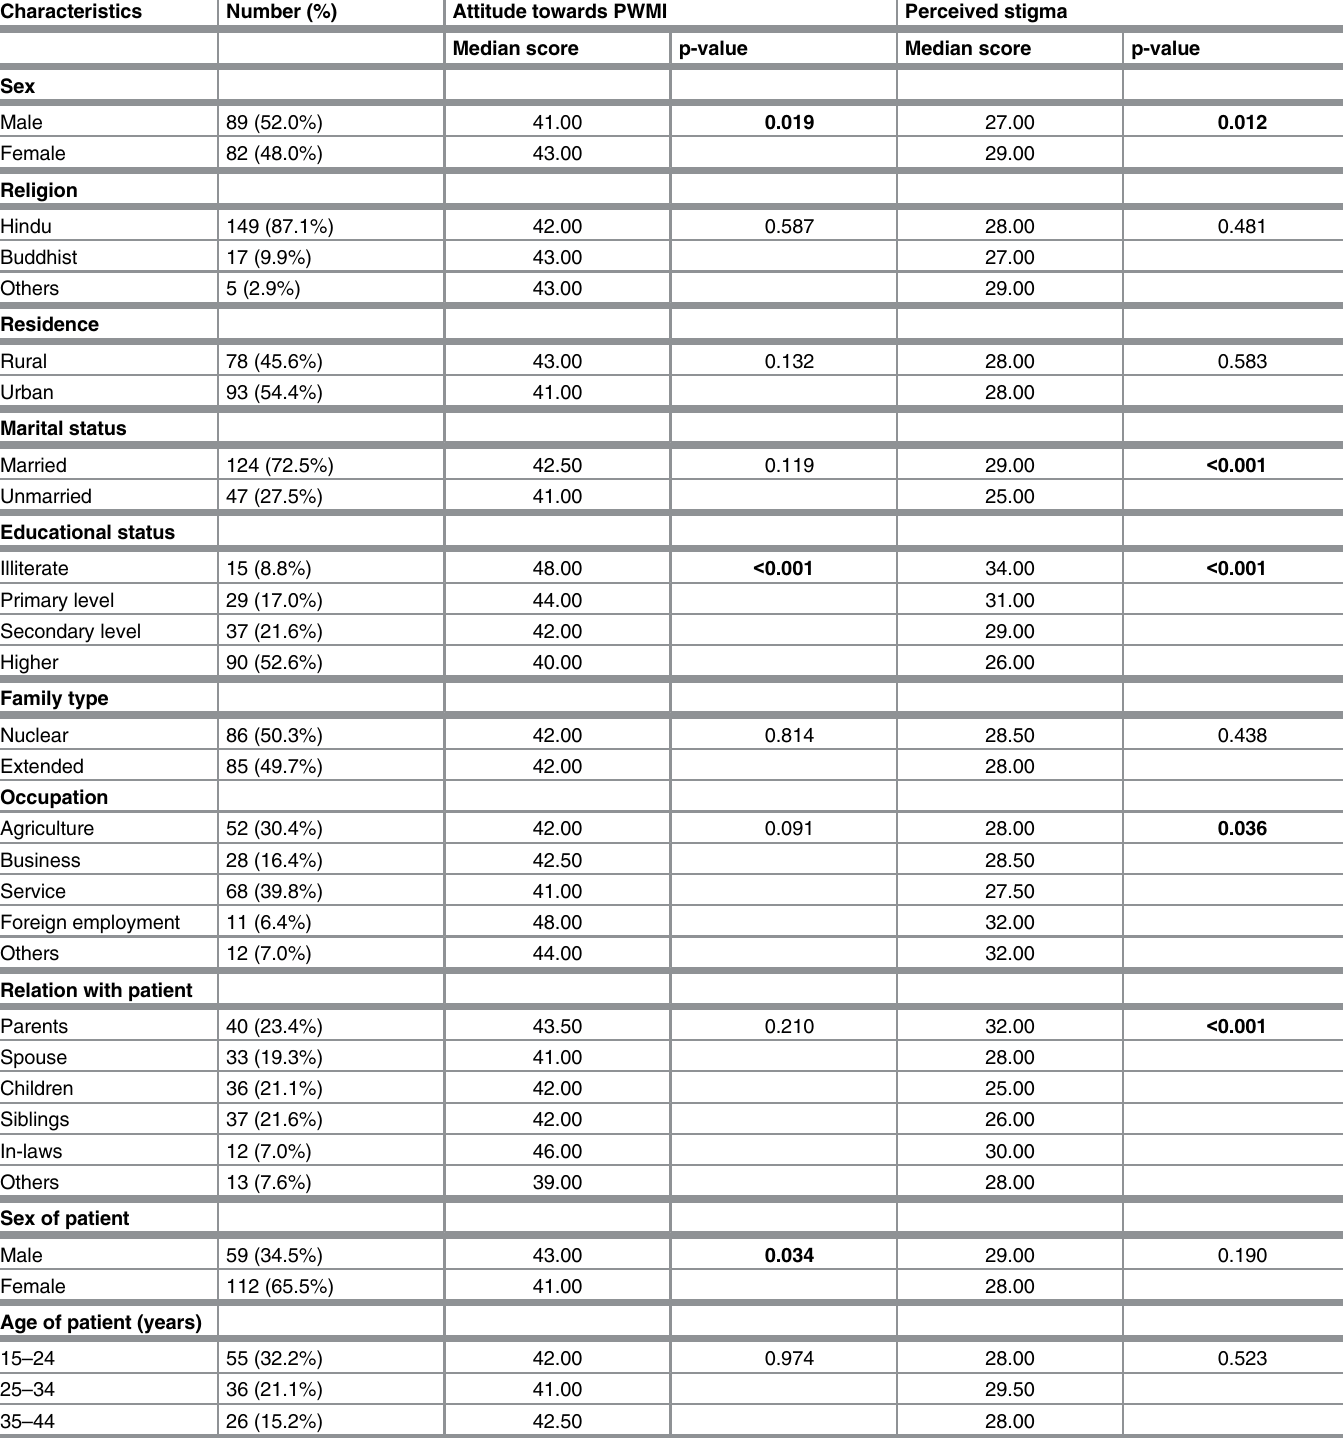
Table 1. Socio-demographic characteristics in relation to attitude towards PWMI and perceived